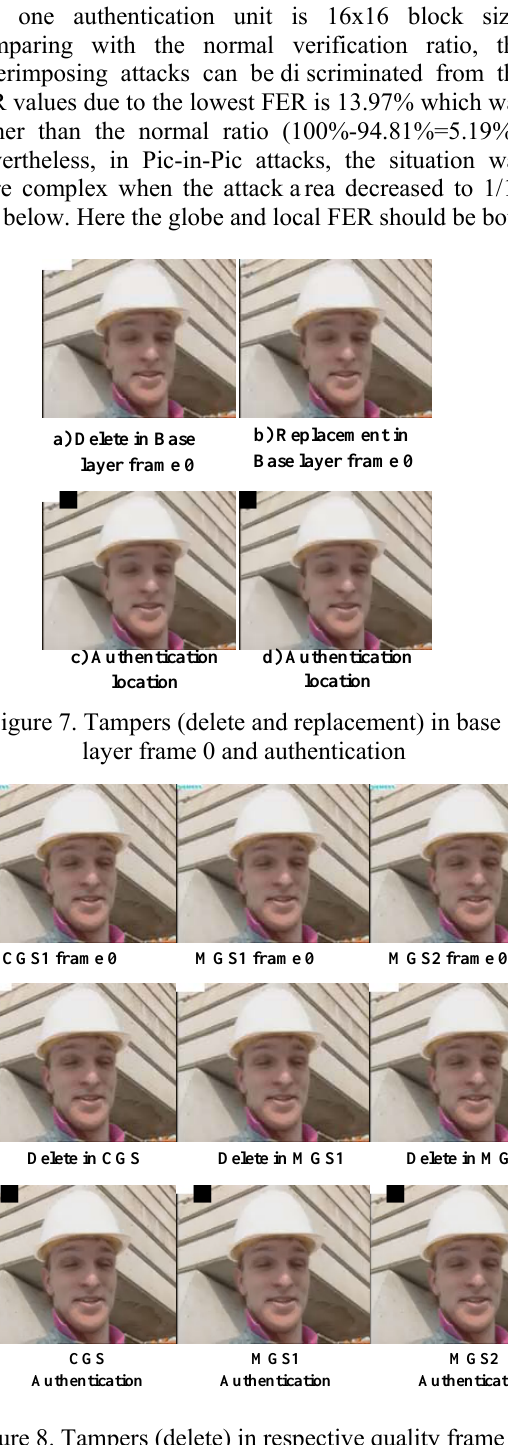
Figure 8. Tampers (delete) in respective quality frame